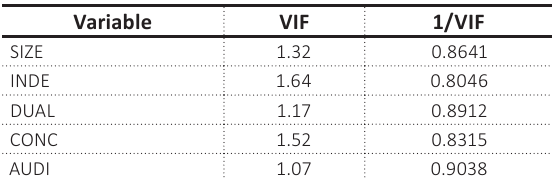
Table 4. Variance inflation factor of the variables